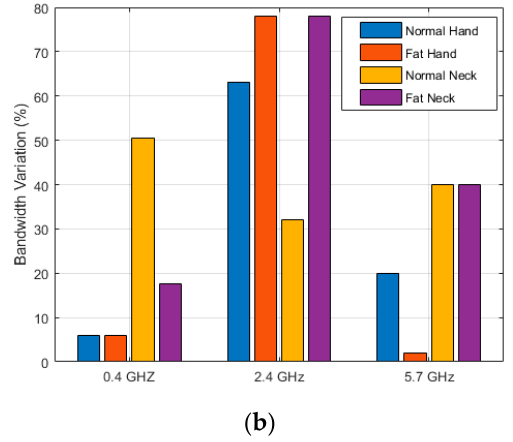
Figure 5. Performance comparison of the meandered and comb antennas for different placements of the antennas in the human voxel model and in the three-layer phantom model. ( a ) Meandered antenna’s resonant frequency alteration percentage at each frequency band ( b ) Meandered antenna’s bandwidth alteration percentage at each frequency band ( c ) Comb antenna’s resonant frequency alteration percentage at each frequency band ( d ) Comb antenna’s resonant frequency alteration percentage at each frequency band, and ( e ) Positions of antenna’s placement in the human voxel.